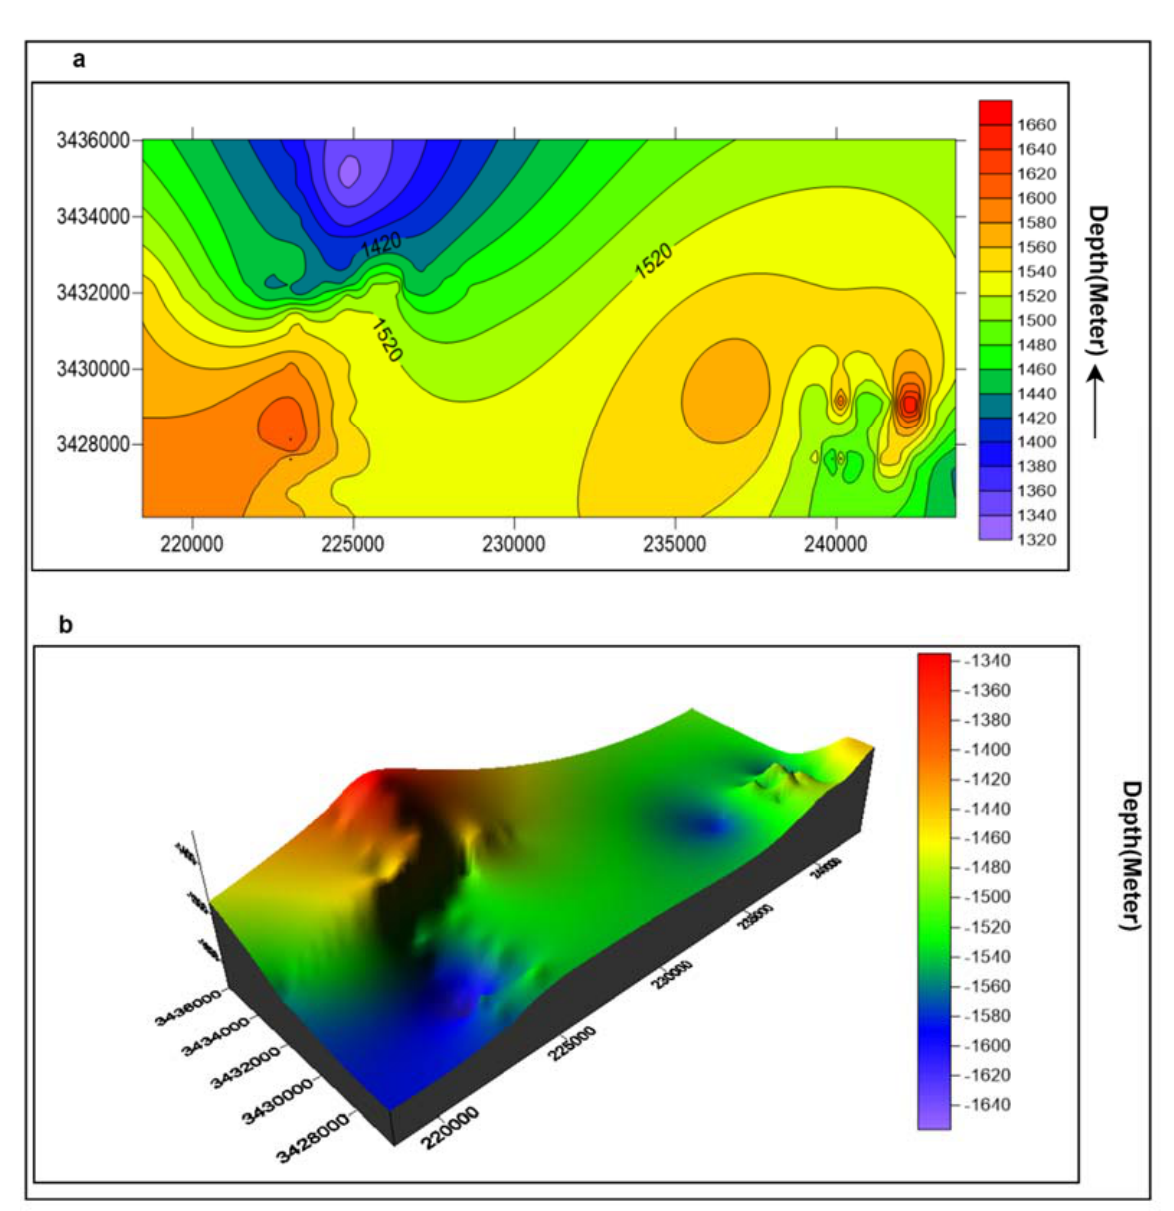
Figure 12. ( a ) Depth contour map of the Dunghan formation. ( b ) Depth surface map of the Dunghan formation. 4.9. Depth Contour and Depth Surfaces Maps of Samana Suk Formation The depth contour map of the Samana Suk formation points out descending depth northward from 1450 to 1180 m, as shown in Figure 13a. The depth contour surface of the Samana Suk formation was generated by joining the points of equal depth. These depth values were assigned a color bar, which can be used as a guide for interpretation. On the color bar, red shows the shallowest point and purple-blue shows the deepest point (Figure